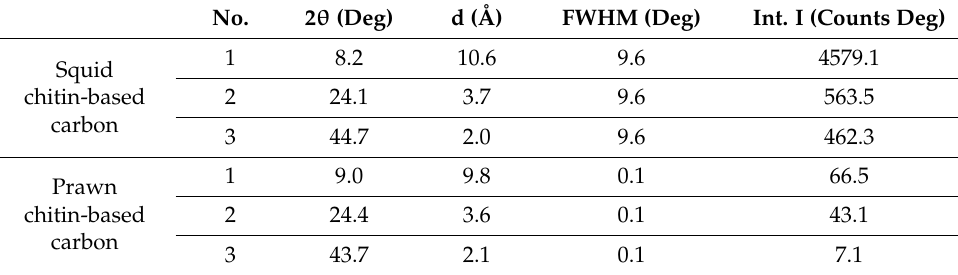
Table 3. Peaks are extracted from the diffraction pattern that is represented in Figure 7.